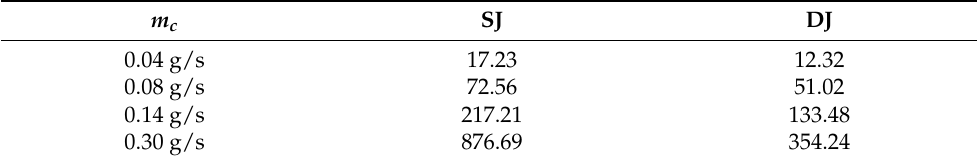
Table 3. The time-averaged flow resistance coefficient of the coolant